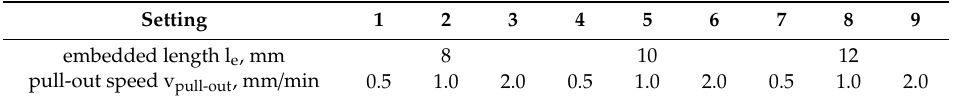
Table 1. Methodical testing plan for FBPO